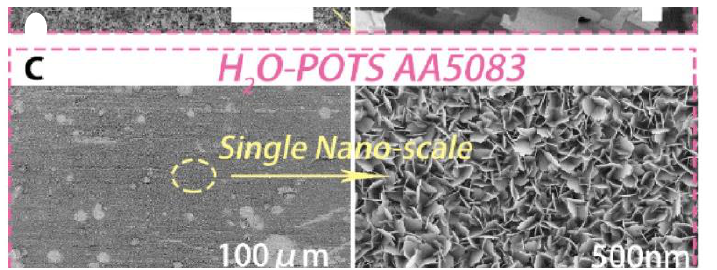
Figure 5. SEM images of aluminum substrates after immersion in boiling water and hydrophobization. Reproduced with permission from [24]. tion. Reproduced with permission from A hydrothermal method was used to compose a superhydrophobic coating of CeO2